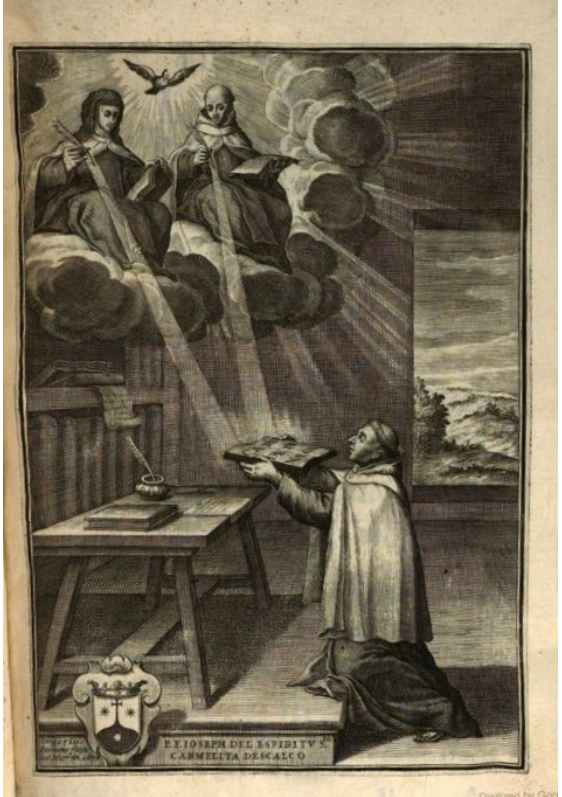
Figure 3. Unidentified artist, Joseph del Espiritu Santo receives a vision of Saint Teresa and Saint John of the Cross , 1678, In Joseph del Espiritu Santo, Cadena Mystica Carmelitana . Credit line: Digitized by Google Books.